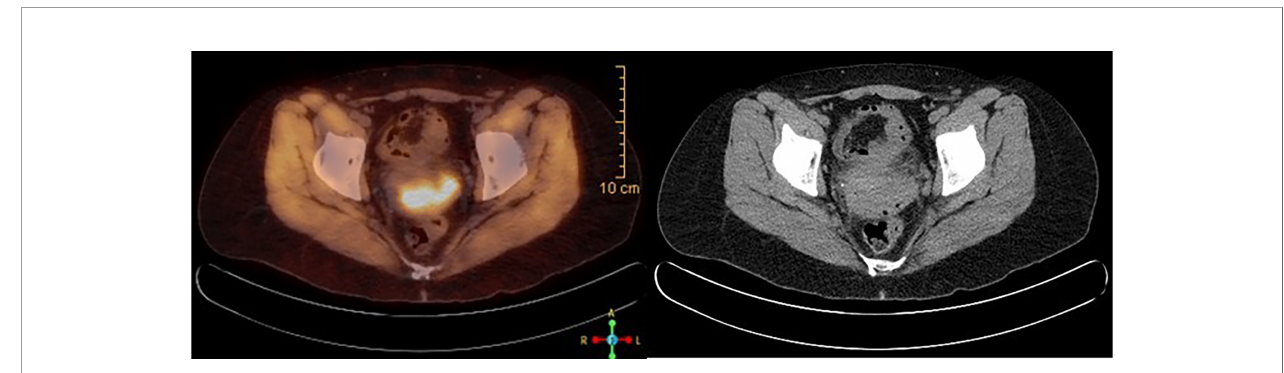
FIGURE 1 | PET/CT scan at the time of diagnosis, showing FDG avid 4.4 × 4.8 × 2.7 cm cervical mass, consistent with known cervical